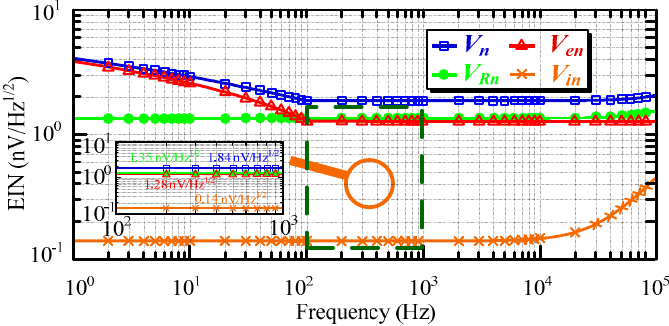
Figure 10. Noise sources of air-core coil sensor (ACS) using AD797.